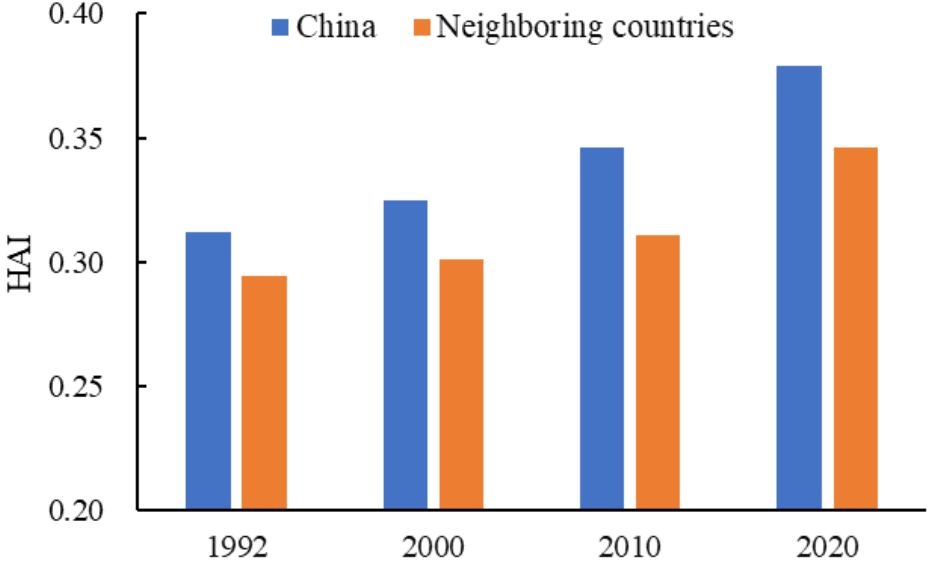
Figure 3. Overall changes in the study area between China and its neighboring countries.